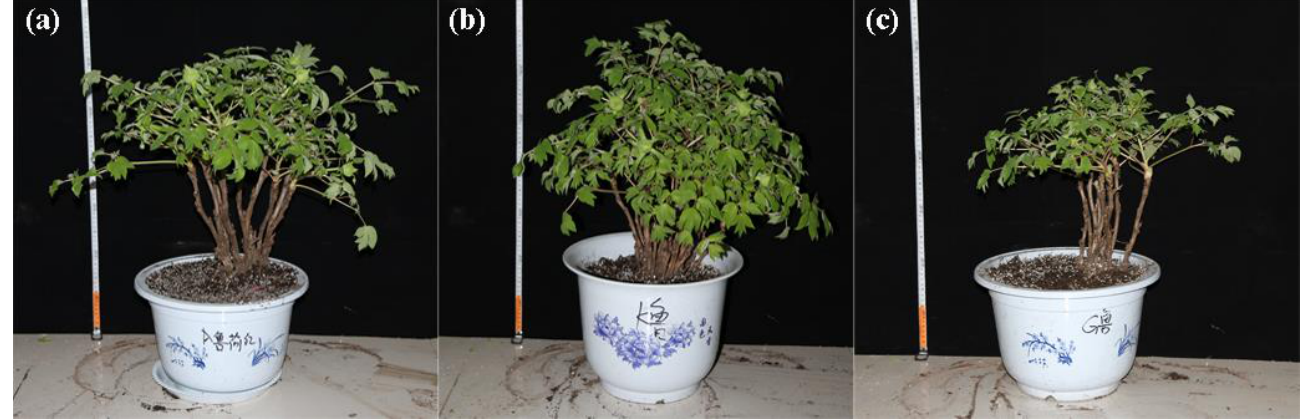
Figure 1. Three groups of peonies used for metabolome determination. ( a ) Group A; ( b ) Group K; ( c ) Group G.